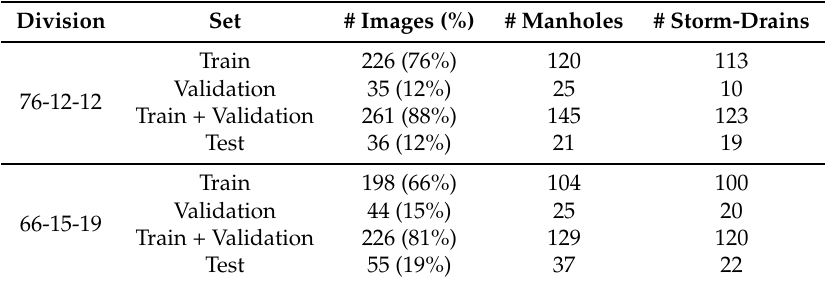
Table 1. Distribution of the number of (#) images and classes on training, validation and testing data-sets for the division 72-12-12 and